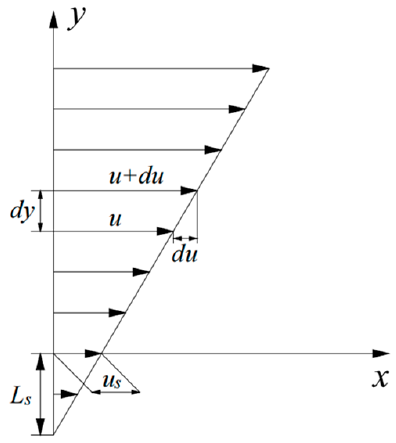
Figure 6. One-dimensional slip velocity.